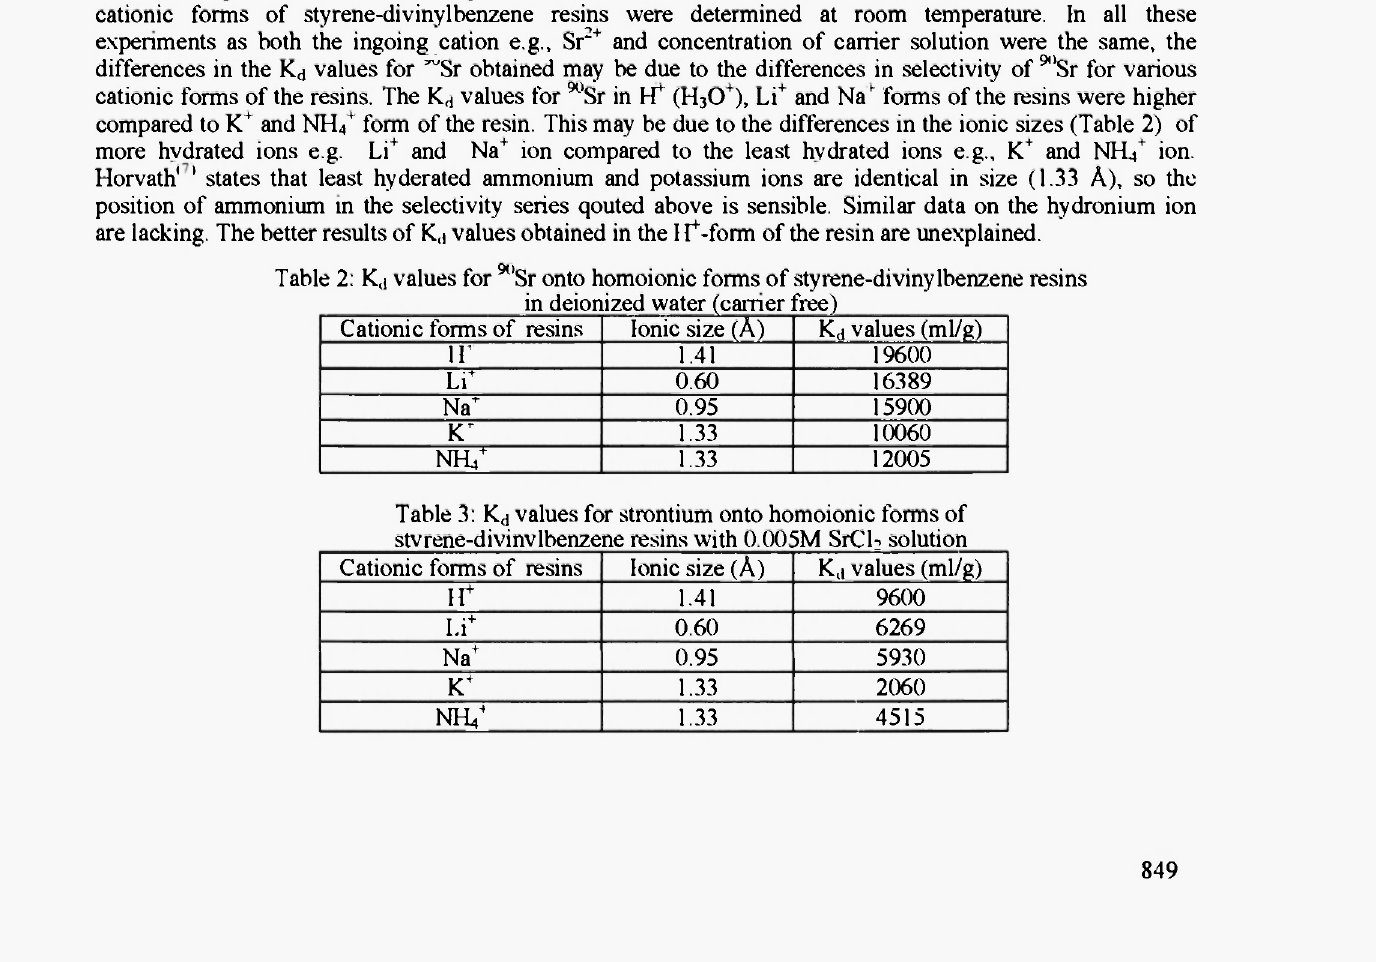
Table 3: K d values for strontium onto homoionic forms of stvrene-divinvlbenzene resins with 0.005M SrCl?